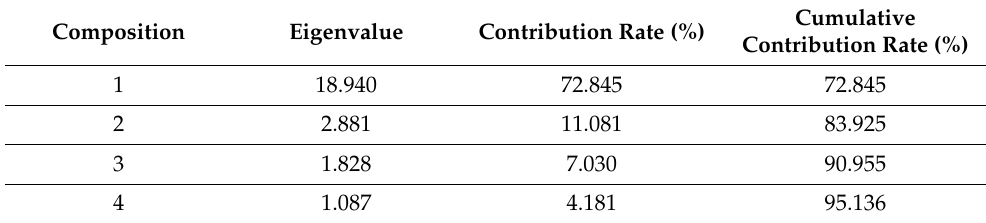
Table 3. Eigenvalues and principal component contribution rates.